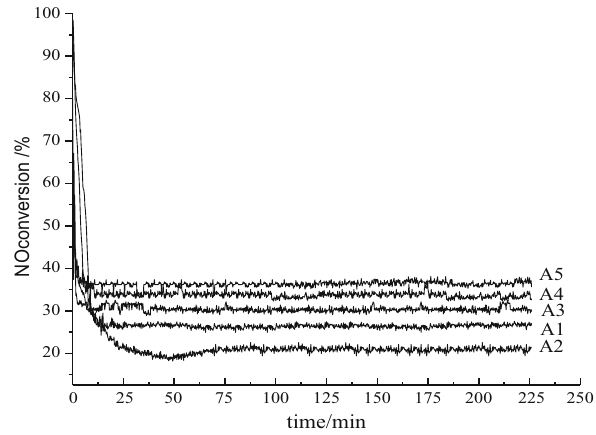
Fig. 4 Reaction profiles of NO conversion over the activated cokes